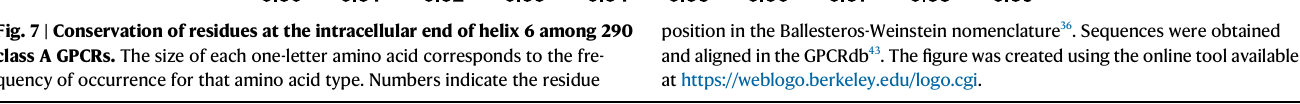
position in the Ballesteros-Weinstein nomenclature 36 . Sequences were obtained and aligned inthe GPCRdb 43 . The fi gurewascreated using the online toolavailable at https://weblogo.berkeley.edu/logo.cgi.